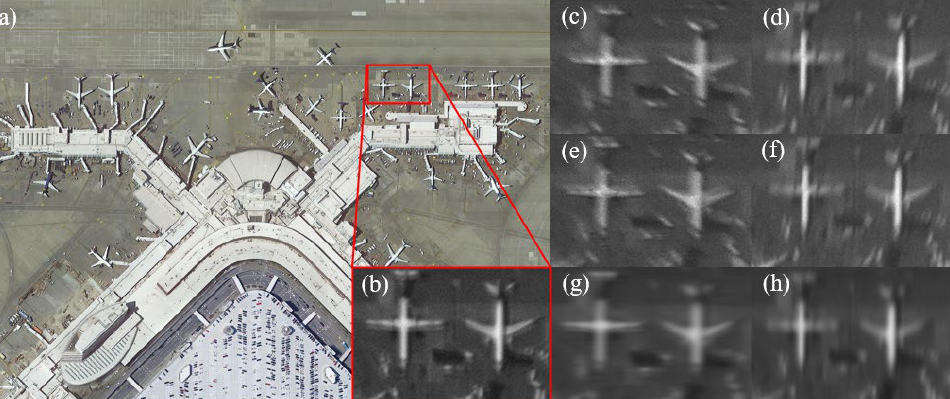
Figure 12. Simulation results when the pupil’s length–width ratio is 10. ( a ) Original scene, ( b ) real image taken by the circular primary mirror, ( c ) real image when the angle of rotation is 0°, ( d ) real image when the angle of rotation is 90°, ( e ) simulation image obtained by the CCNN when the angle of rotation is 0°, ( f ) simulation image obtained by the CCNN when the angle of rotation is 90°, ( g ) simulation image obtained by the PSF-conv method when the angle of rotation is 0°, ( h ) simulation image obtained by the PSF-conv method when the angle of rotation is 90°.